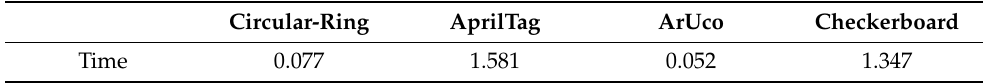
Table 4. Average processing time of single marker image